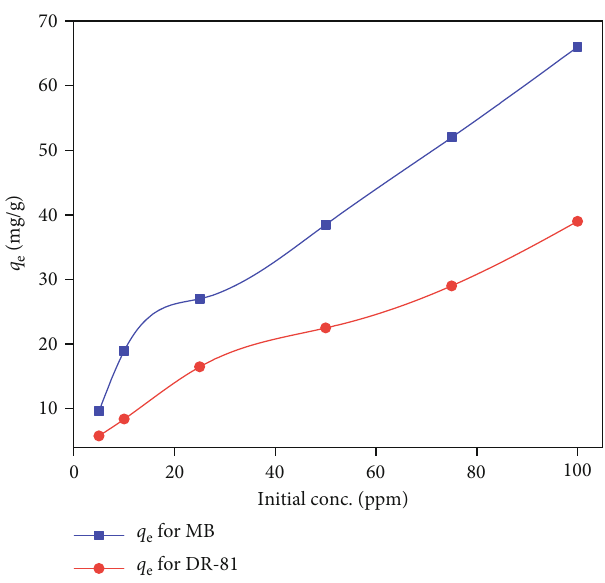
Figure 11: E ff ect of initial concentrations of the dyes on the adsorption capacity of the fabricated Zn-adeninate bio-MOF for MB and DR-81 (contact time = 10 min for MB and 30min for DR-81, pH = 7 , bio-MOF dosage = 0 : 5 gL − 1 for MB and 1 gL − 1 for DR-81, stirring speed = 300 rpm, and solution temperature = 23 ° C).